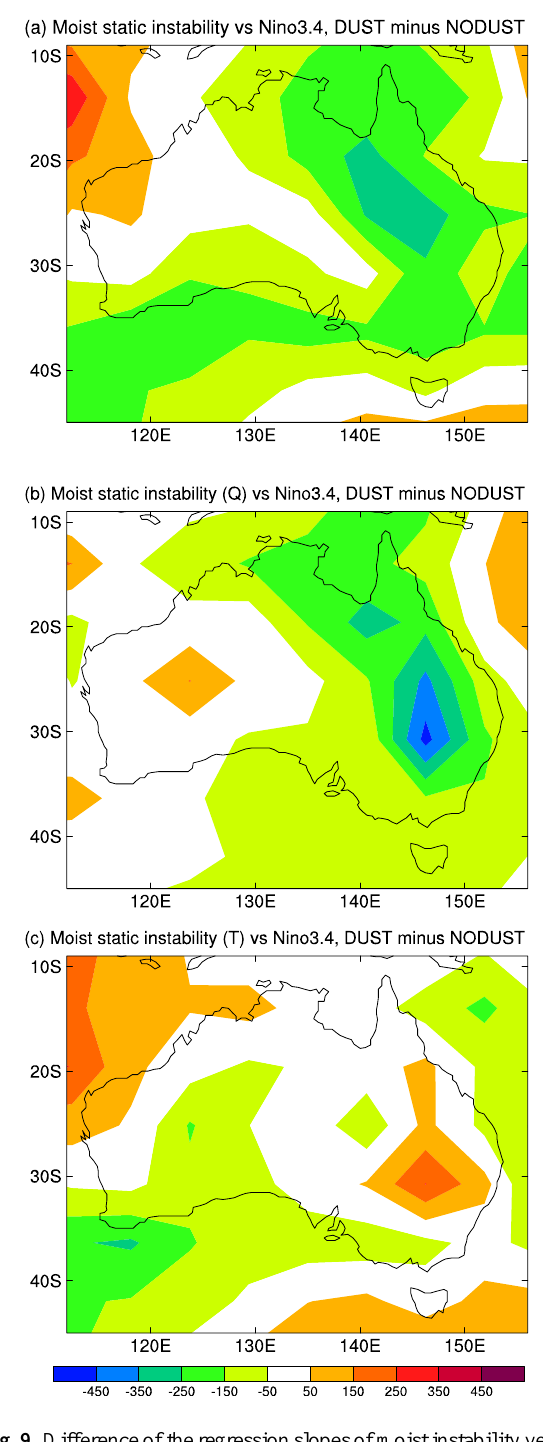
Fig. 9. Difference of the regression slopes of moist instability versus Ni˜no3.4 SST between the DUST and NODUST runs for SON (in Jkg − 1 K − 1 ). Moist instability is defined as the difference of moist static energy (Jkg − 1 ) between near-surface air and the 700hPa level: (a) based on total moist static energy, (b) contribution of moisture changes, (c) contribution of temperature